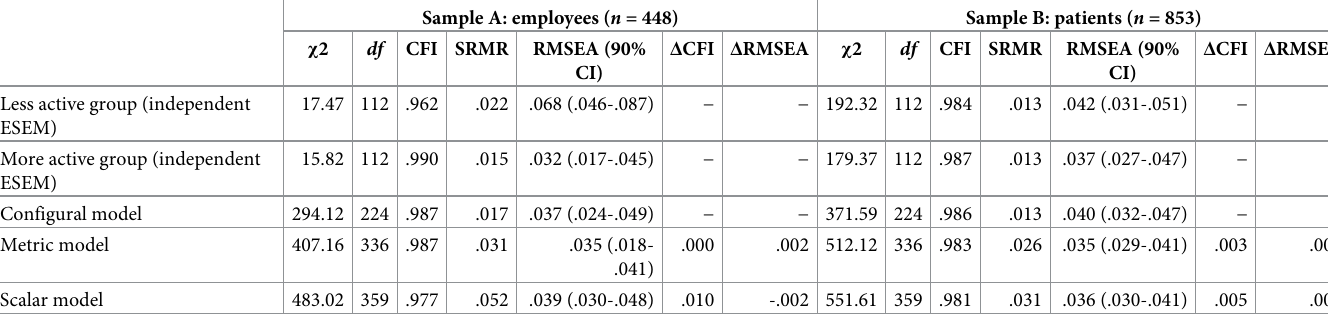
Table 7. Analysis of invariance of the updated version of the BMZI across exercise levels. Sample A: employees ( n = 448) Sample B: patients ( n =